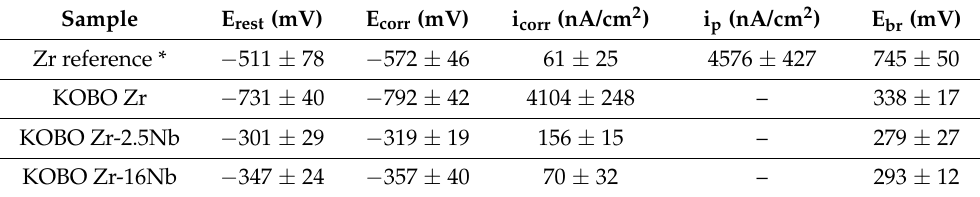
Table 7. Estimated currents and potentials describing the corrosion behaviour of the